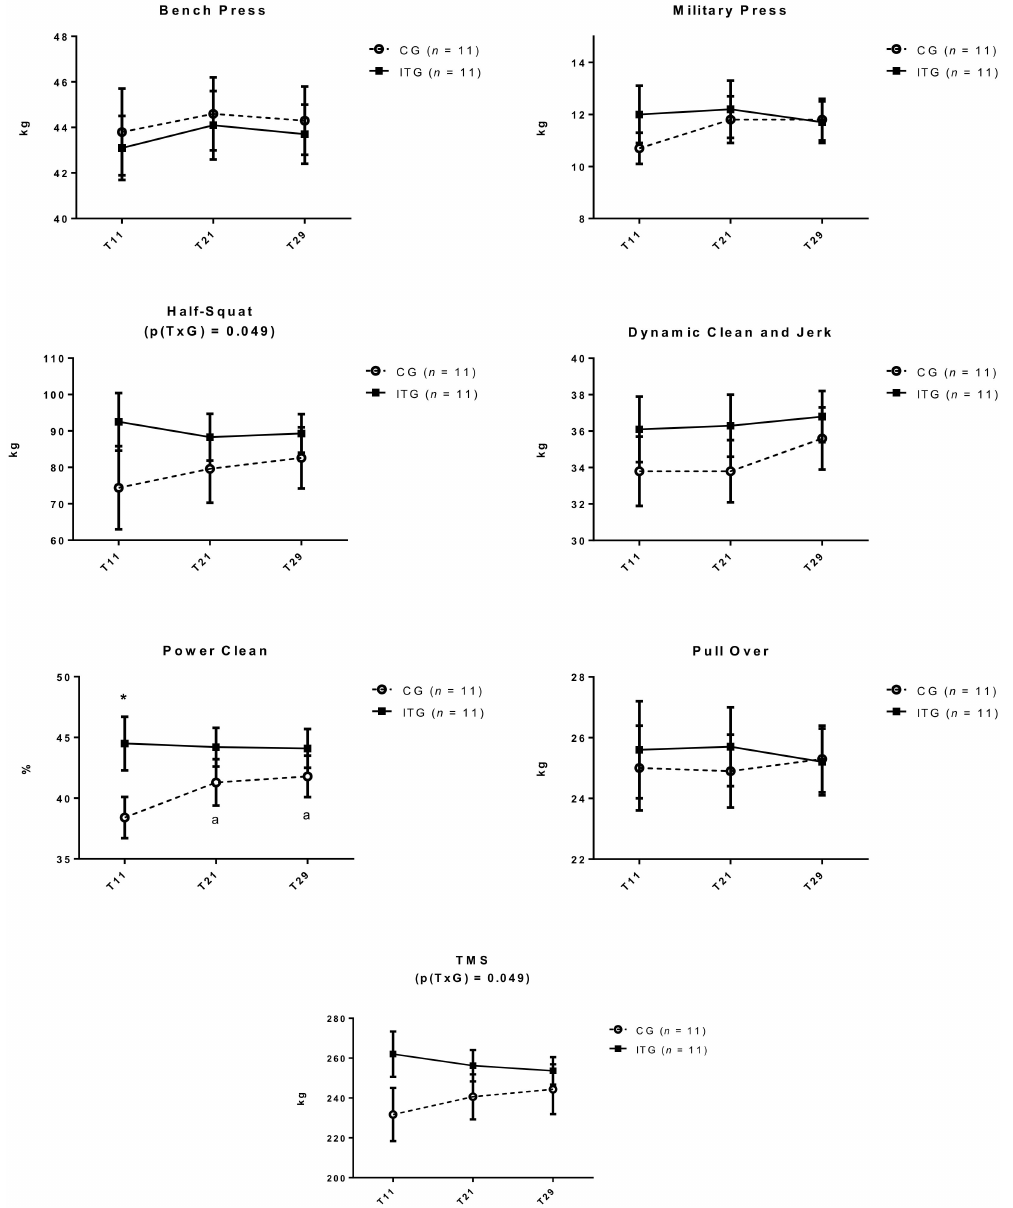
Figure 3. Changes in Strength Performance Tests in control group (CG) and iron treatment group (ITG) at T11, T21, and T29. Data are expressed as mean and standard error. TMS: Sum of all strength tests divided by 6. p(TxG) indicates interaction between treatment and time. * Significant differences between